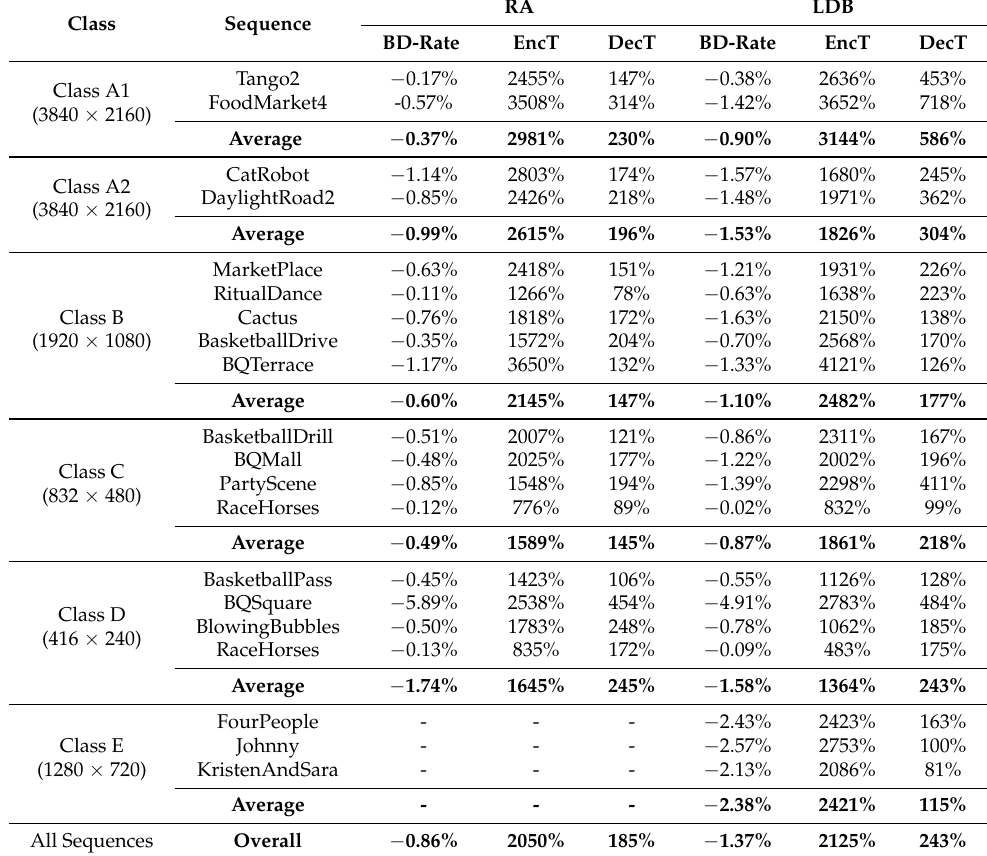
Table 5. BD-rate reduction and encoding/decoding computational complexity compared to VTM-11.0 NNVC-1.0